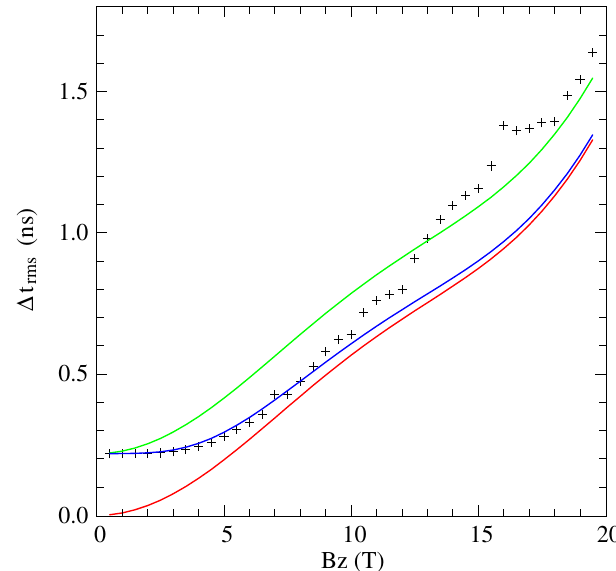
FIG. 8. Comparison of the simulated (plusses) and analytic calculation (red, green, and blue curves) of (cid:1) t rms for a beam with finite extent, axial velocity tilt, normalized edge emittance of 2 (cid:4) mm mrad , 3.5 cm radius, and 1.2 MeV. The solenoid is nearly hard edged. The green curve is the sum and the blue the geometric sum of the analytic solution and (cid:1) t rms from the simulation with no solenoid field. The analytic (cid:1) t rms does not include either the tilt or the thermal